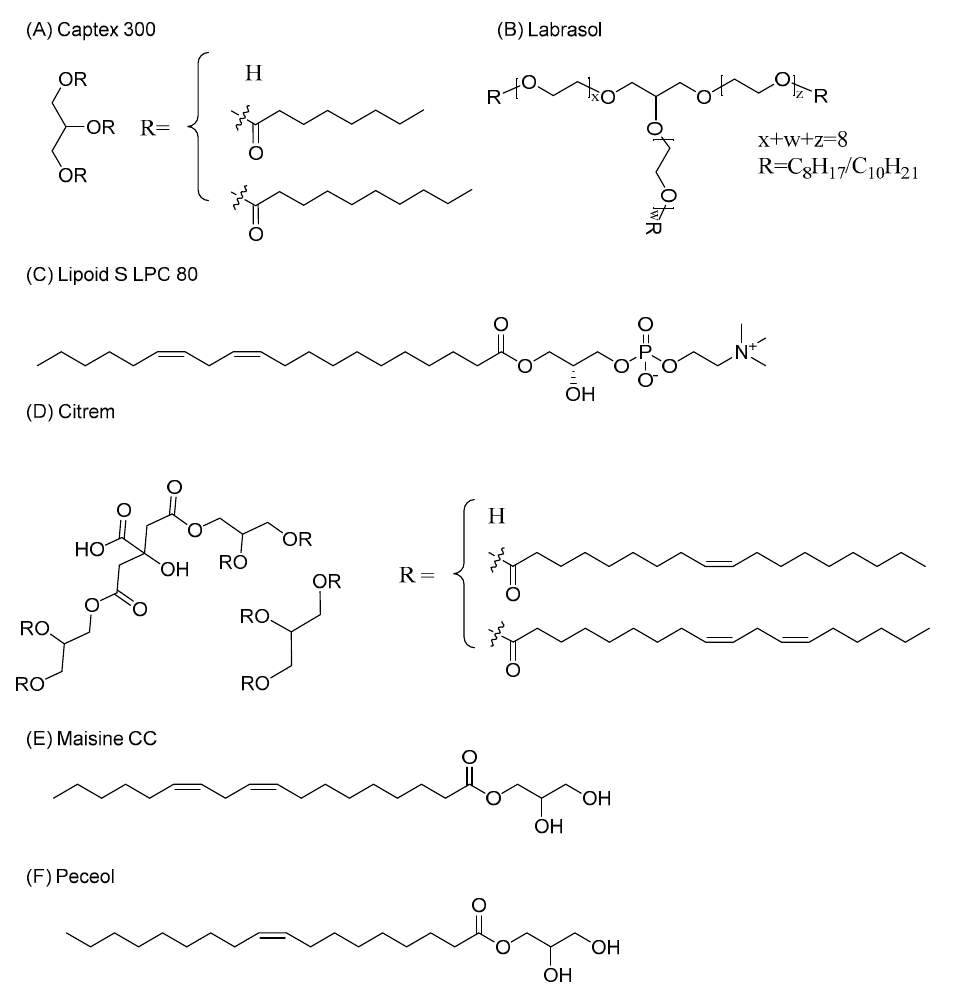
Figure 2. Chemical structures of SEDDS excipients (the structure of Labrasol was adapted from [36], and the structure of Citrem was adapted from [37]). Table 1. Composition of the self-emulsifying drug delivery systems (SEDDS).